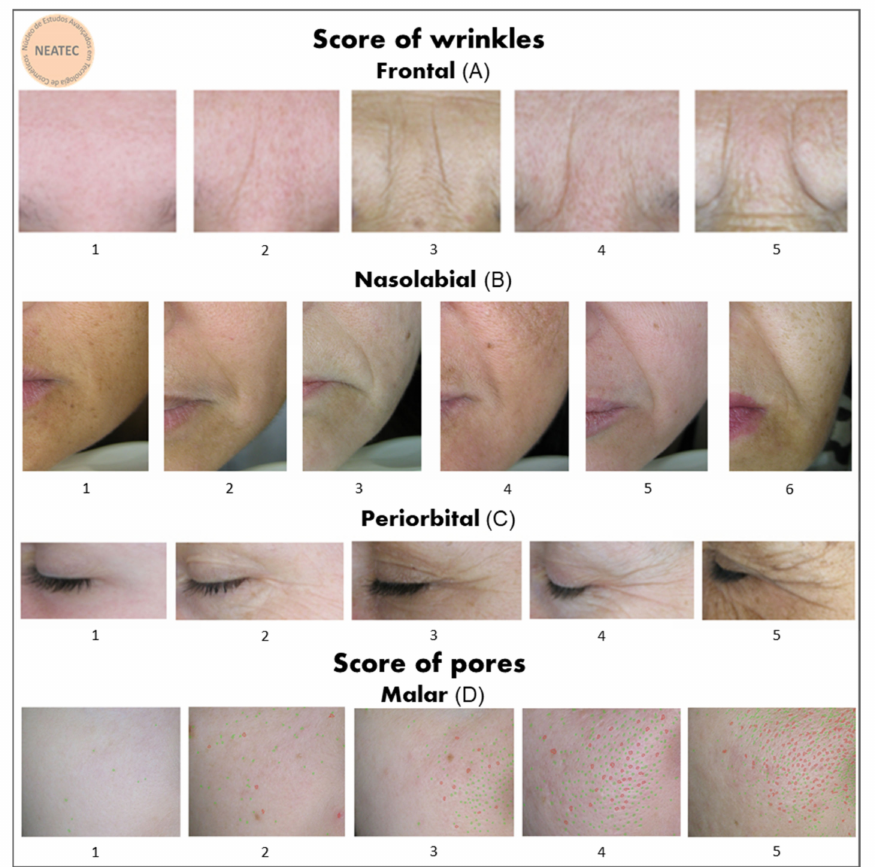
Figure 11. Wrinkle score in the frontal ( A ), nasolabial ( B ), and periorbital ( C ) regions of the skin and pore score in the malar ( D ) region of the skin obtained by